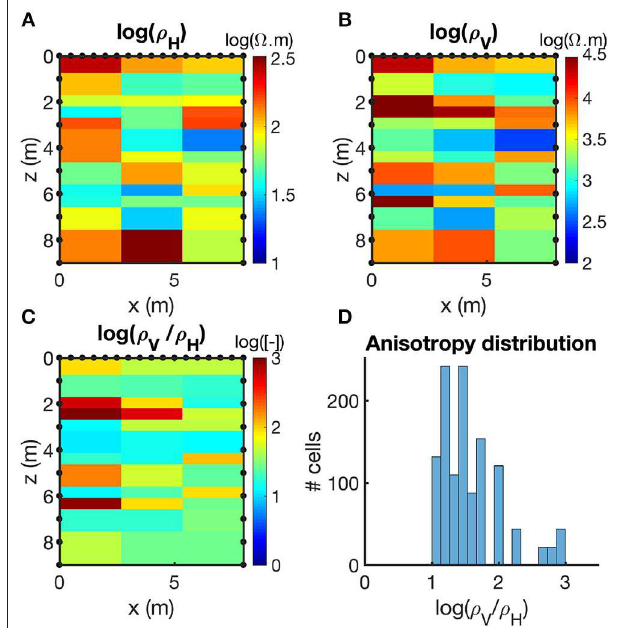
FIGURE 3 | Electrical resistivity synthetic model based on real case hydraulic study results from Paradis et al. (2016a). The horizontal (A) and vertical (B) resistivities ρ H and ρ V are the components of the anisotropic resistivity tensor ¯¯ ρ . The anisotropy (C) shows locally up to three orders of magnitude. Black dots represent the electrodes locations. The distribution of anisotropy is represented on the histogram (D) .